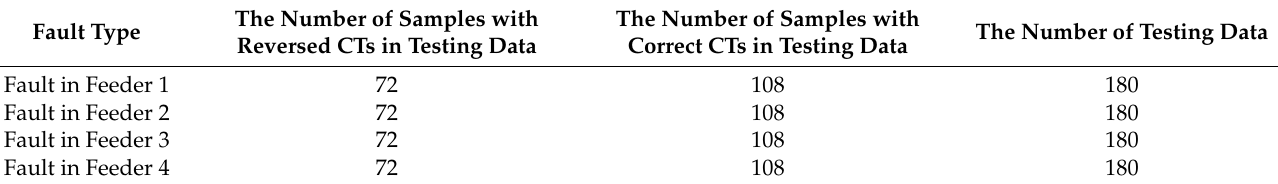
Table 6. Test data distribution table for CTs with reversed connections.